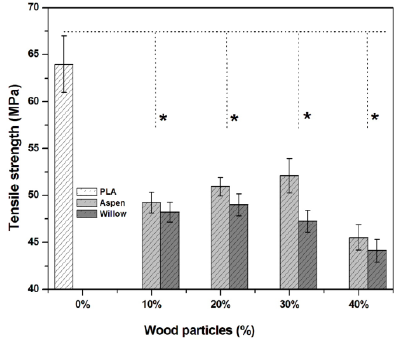
Figure 3. Tensile strength comparison between different species. (* Significant difference at P < 0.05)